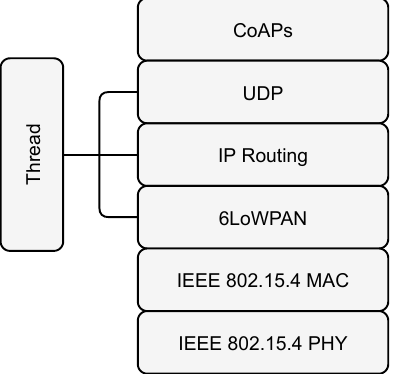
Figure 2. Stack of the Thread